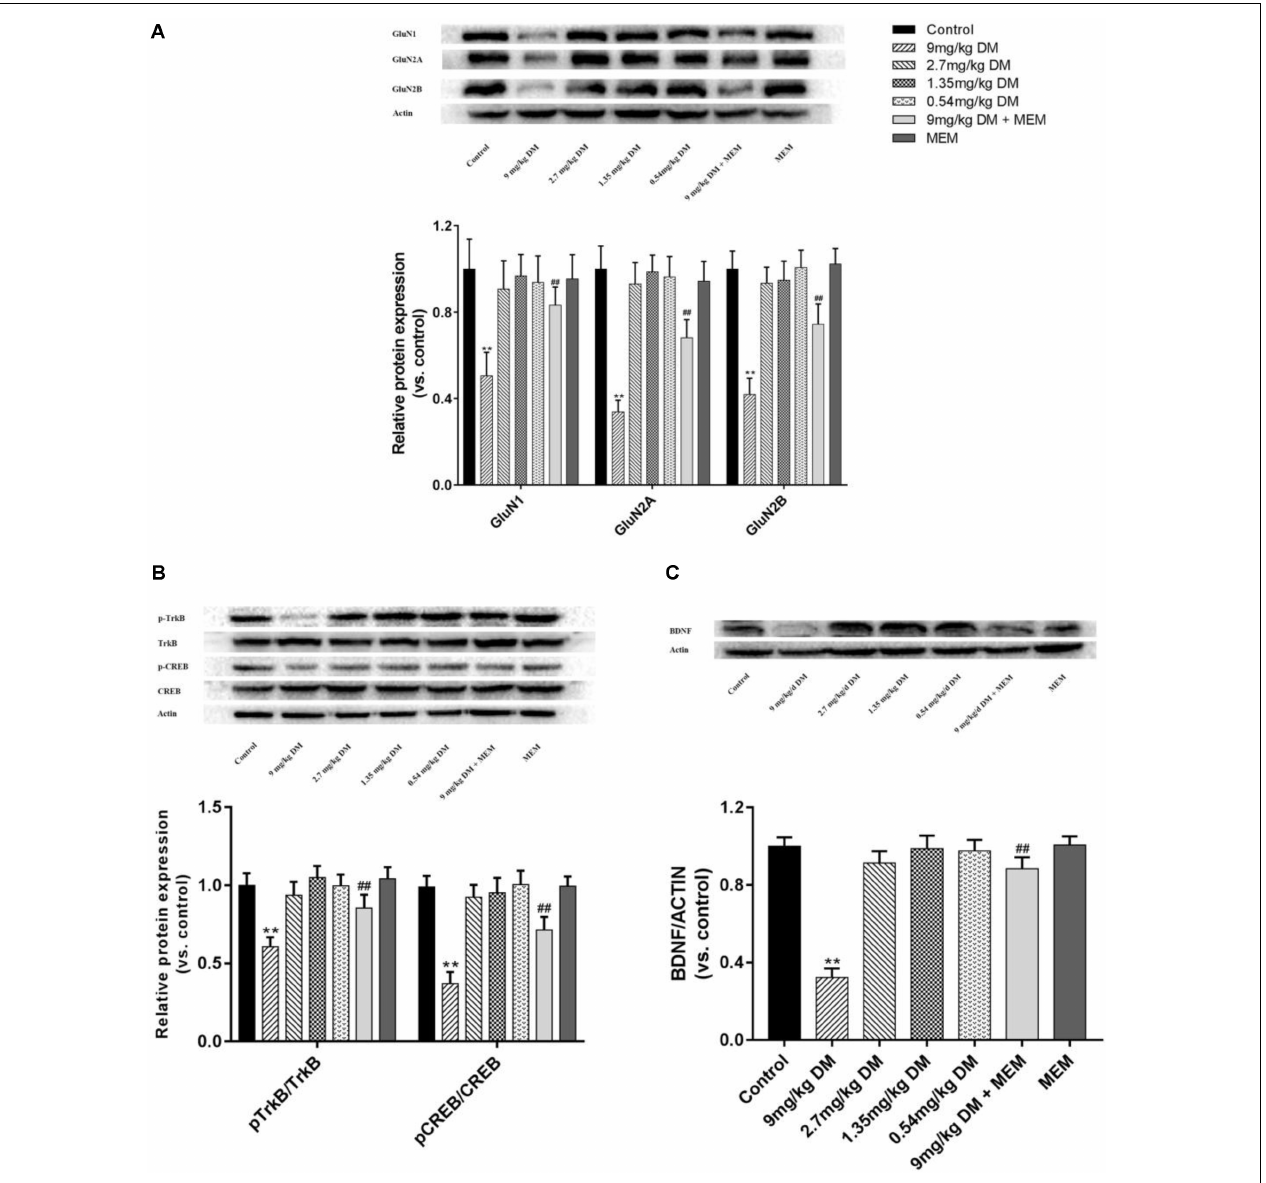
FIGURE 2 | Western blot of protein expression of hippocampus GluN1, GluN2A, GluN2B (A) , pTrkB, TrkB, pCREB, CREB (B) , and BDNF (C) in the hippocampus of offspring. (A) Histogram showing the protein expression of GluN1, GluN2A, and GluN2B in the hippocampus (from left to right). Lanes (from left to right) represent the control, 9mg/kg DM, 2.7mg/kg DM, 1.35mg/kg DM, 0.54mg/kg DM, 9mg/kg DM + MEM, MEM groups. β -actin was used as control. (B) Western blot showing the protein expression of pTrkB, TrkB, pCREB, CREB and the column chart showing the quantification of the pTrkB/TrkB and pCREB/CREB ratio. (C) Western blot results of protein expression of BDNF in hippocampus of the offspring. β -actin was used as control. n = 12 in each group. ∗∗ P < 0.01 when compared with control group. ## P < 0.01 when compared with 9 mg/kg DM group. DM: deltamethrin, MEM: